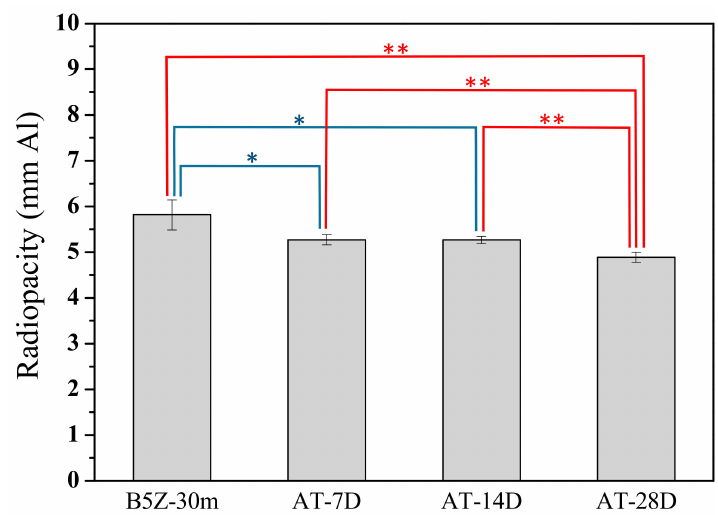
Figure 6. Radiopacity of MTA-like cements stored in an atmospheric environment for 7, 14, and 28 days (i.e., AT-7D, 14D, and 28D, respectively). * and ** indicated that these two sets of samples were statistically di ff erent at a 95% and 99% confidence interval, respectively.